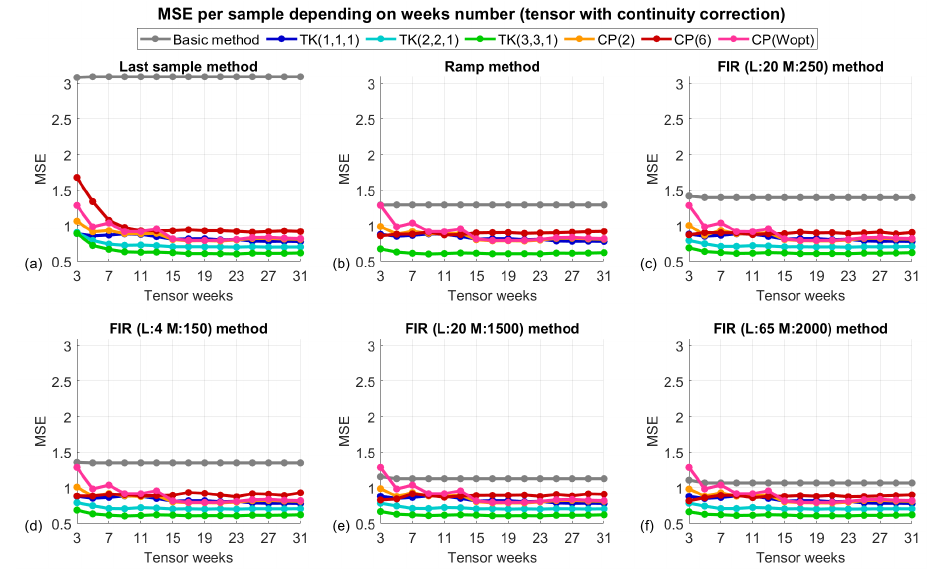
Figure 13. Trend of the MSE with an increaasing number of weeks configured in the tensor. The results are the mean of 1000 simulations. The tensor contains three weeks worth of data (288,7,3). The number of samples in the burst is 100, and the position of the burst was randomly